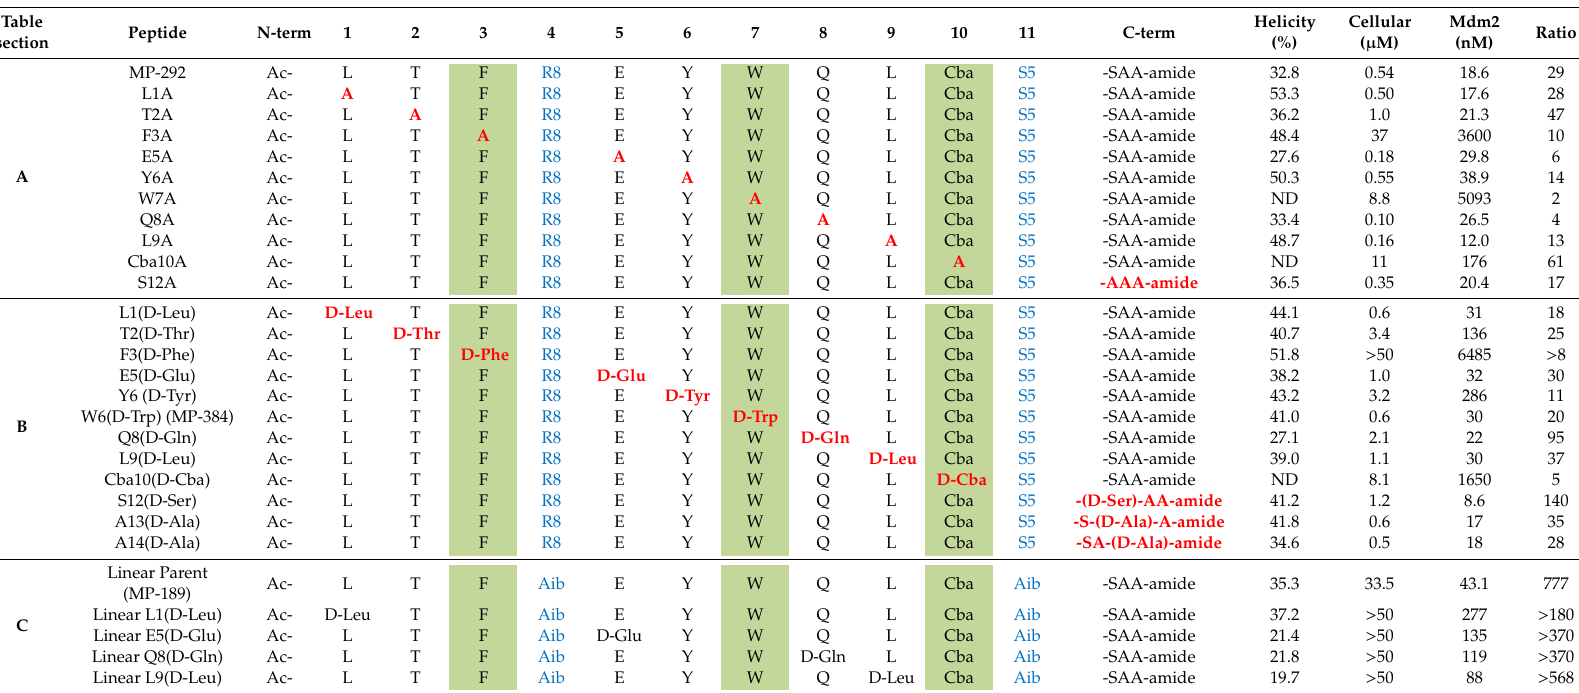
Table 1. Sequence, helicity, cellular activity (EC50), and Mdm2 binding (Kd) of MP-292 and derivatives. Ratio refers to the fold-shift between the binding a ffi nity and cellular activity. Section A) Alanine scan of MP-292 highlights F3, W7 and Cba10 as key residues for Mdm2 binding and cellular activity. Section B) D-amino acid scan of MP-292 shows that most variants maintain Mdm2 binding and cellular activity. Section C) D-amino acids substitutions to MP-189, a linear equivalent of stapled peptide MP-292, disrupt secondary structure and binding to